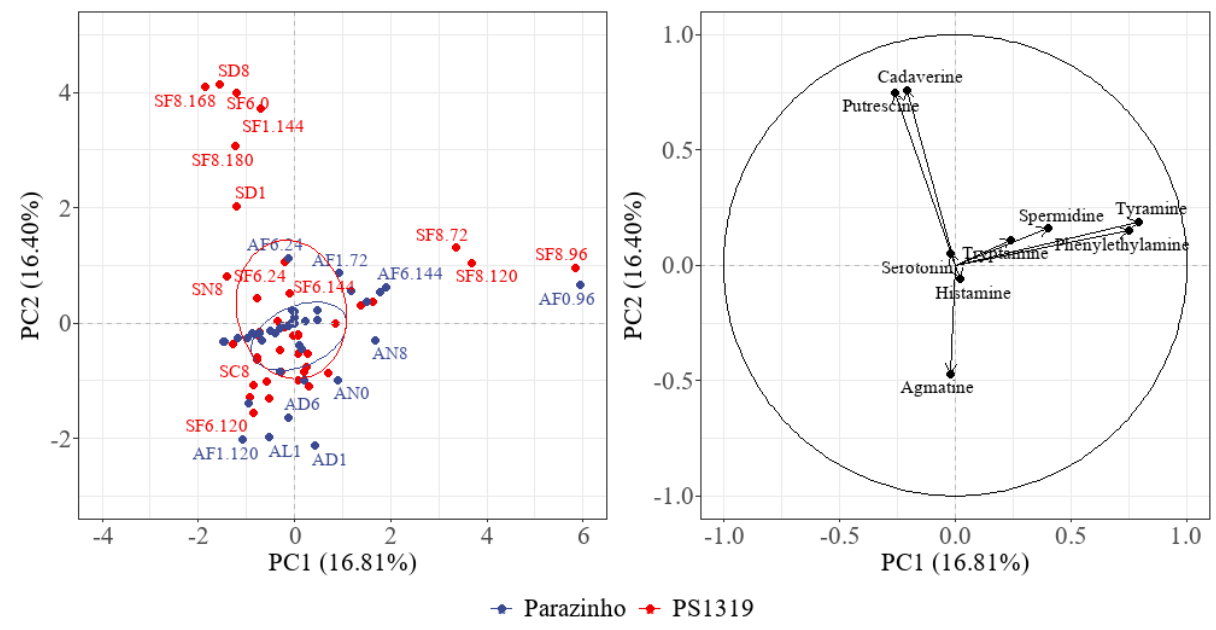
Figure 8. Principal Component Analysis of the bioactive amines during cocoa processing comparing Parazinho and PS 1319 varieties. Note: S: PS 1319 variety. A: Parazinho variety. C: Control (freeze- dried cocoa pulp and seeds). F: fermented. D: Fermented and dried cocoa. N: Nibs (roasted cocoa). L: Liquor. C Chocolate. 1: 100% pulp. 8: 80% pulp. 6: 60% pulp. 0: 0% pulp. F: Fermentation. 24, 48, 72, 96, 120, 144,156, 168, 180: fermentation times.